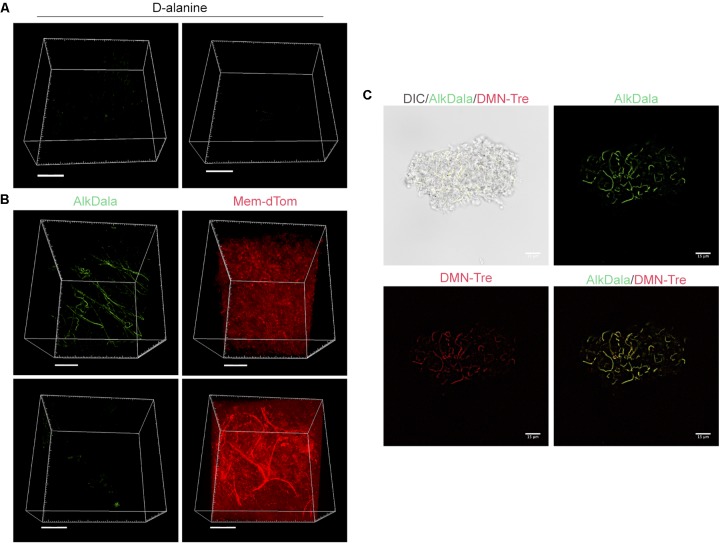
Filamentous structures identified on conjunctiva are not host tissue. (A) Mouse eyes incubated in D-alanine, without an alkyne, resulted in no fluorescent labeling. (B) Wild-type transgenic mice with fluorescent red cell membranes mT/mG knock-in mice (Muzumdar et al., 2007) were used in conjunction with alkDala labeling to determine if the filaments identified on the conjunctiva colocalized with host tissue. Filamentous structures on the conjunctiva (Upper) did not colocalize with host cell membranes (denoted Mem-dtom). Conversely, when filament-like structures were present in host tissue, alkDala labeling was not present (Lower). Images shown on the left and right are of the same fields of view with different emission filters. (C) Imaging of murine conjunctival epithelial tissue shows that DMN-Tre, a probe specific for Corynebacterineae (red), labeled most of the same conjunctival forms as alkDala (green). All images are from the same field of view with different emission filters.